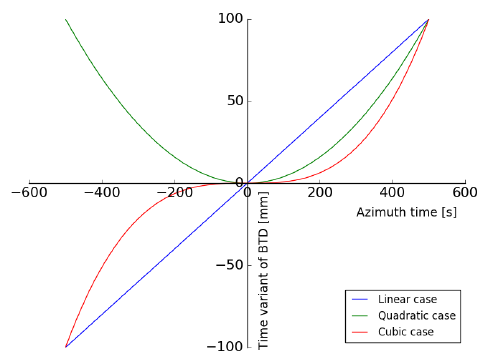
Figure 7. Typical cases of the time variant error of BTD (linear variation, quadratic variation, and cubic